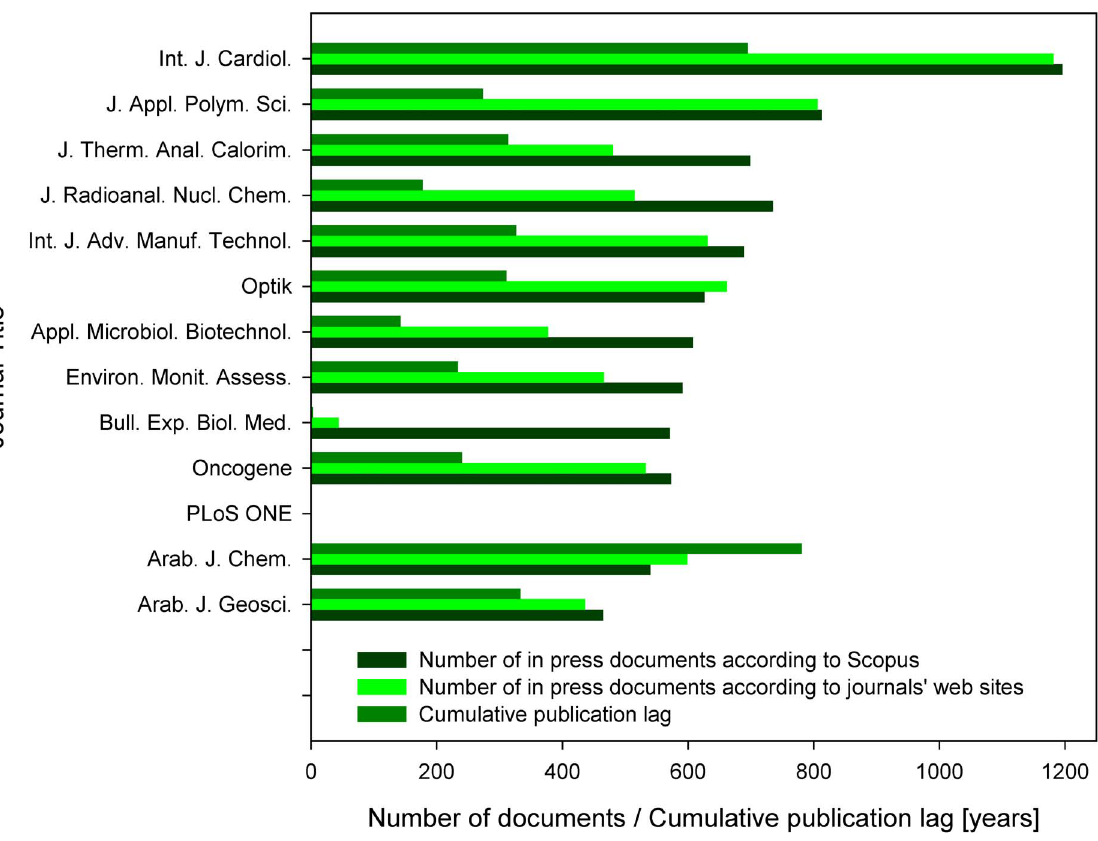
Figure 2. Number of documents in press. Indicated are the numbers of documents in press included in Scopus, numbers of documents in press released at the journals’ web sites, and the cumulative publication lags obtained by summarizing the evidence for publication lag for all the in press documents released at the journals’ web sites (shown in years). Analyses included 13 journal titles representing ten journals with the highest total number of in press articles, three journals with the highest number of in press articles released in 2010 or 2011 and the online-only journal PLoS ONE . Cumulative publication lag ( S L ) of a particular journal was calculated by summarizing the evidence for publication lag ( L i ) of all the in press documents analyzed ( S L =L 1 + L 2 + … + L n